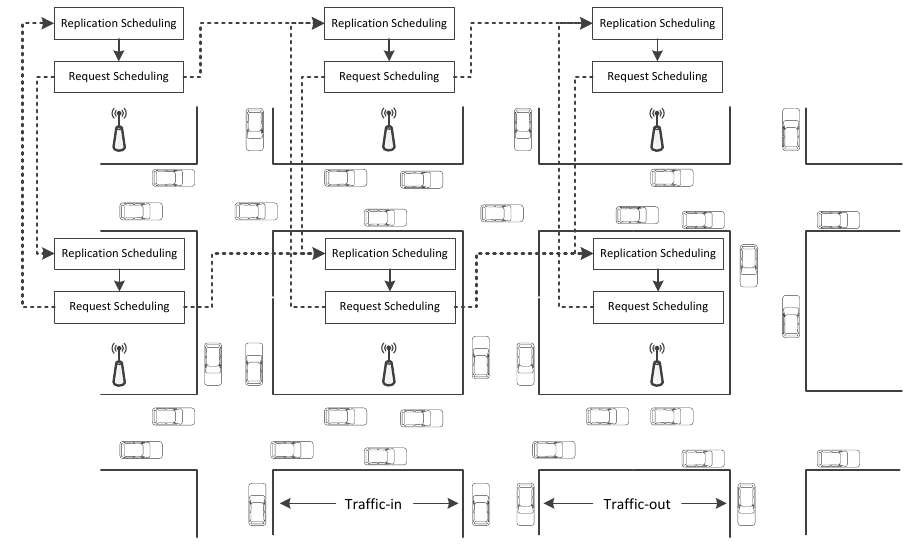
Figure 7. Distributed online